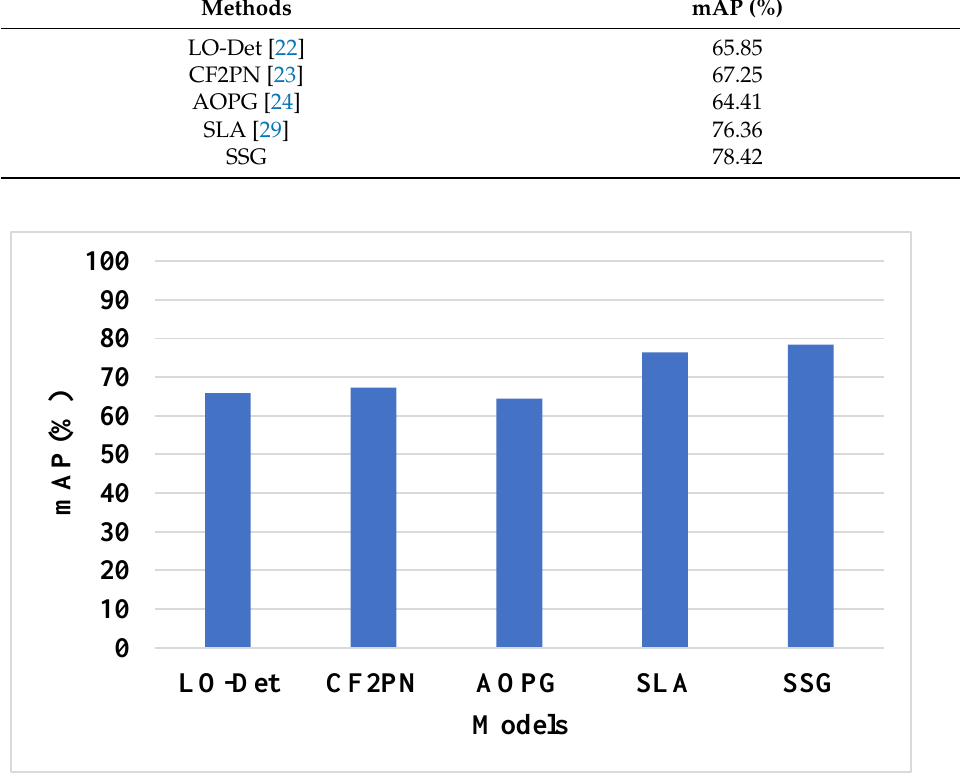
Figure 11. Existing methods comparison on DIOR dataset.